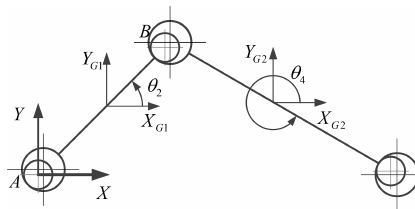
Figure 10. Deployable structure with clearance joints.